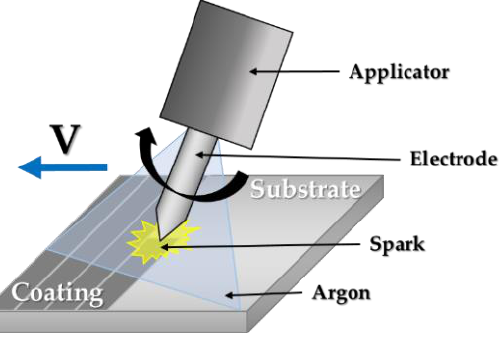
Figure 1. Graphic representation of the electro spark deposition technique.